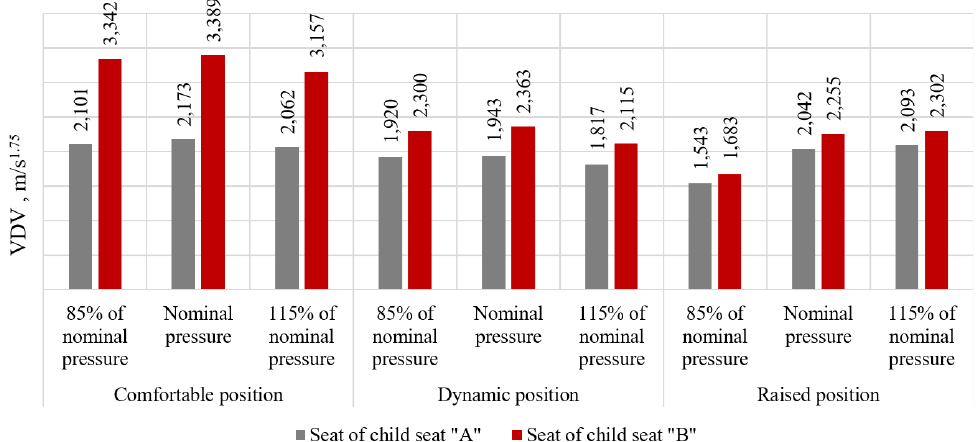
Figure 16: VDV index for vehicle seats that were loaded with a mass of 15 kg during the